Question: Describe this figure in one sentence.
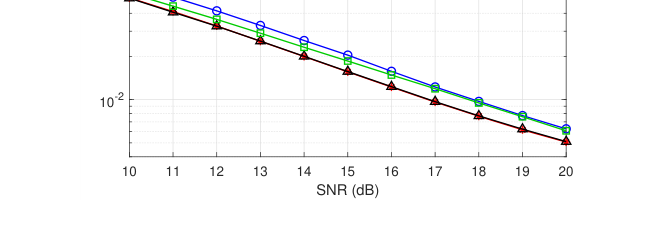
Answer: shows the BER performance of the decoding schemes with convolutional codes in Rayleigh fading channels. The proposed soft-decision decoding scheme outperforms the